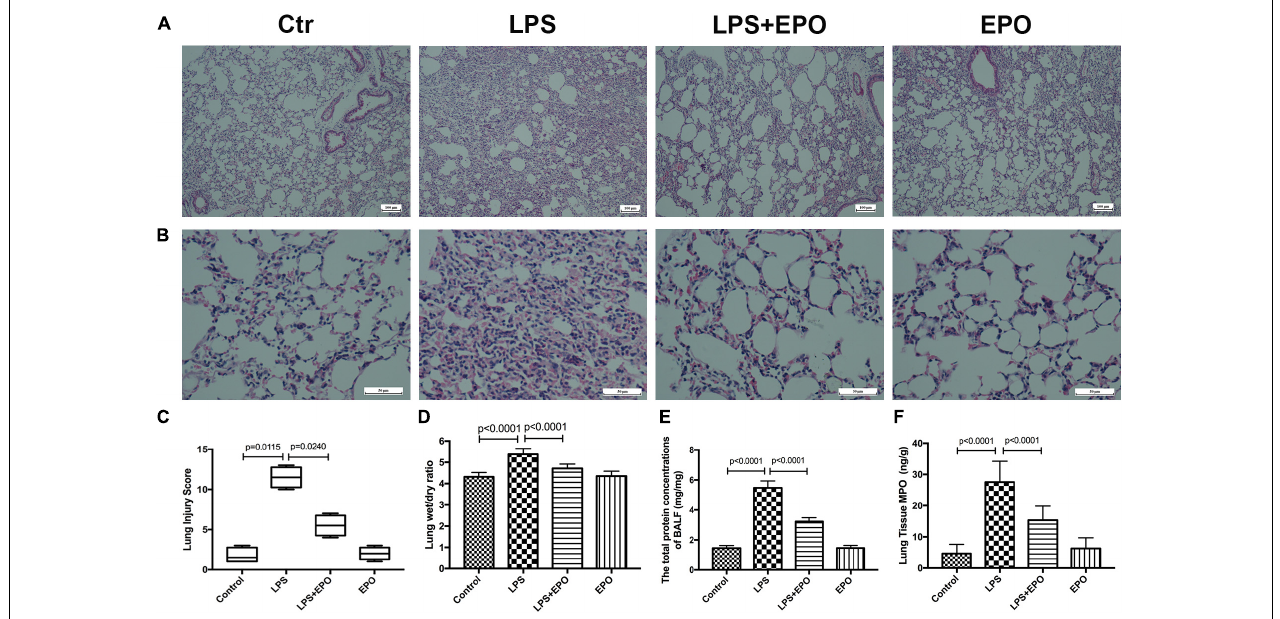
FIGURE 1 | EPO mitigated LPS-induced acute lung injury in mice. EPO (5 U/g) was injected into the peritoneal cavity of mice after LPS (15 mg/kg) stimulation. The mice were sacrificed 8 h later, and the effects of EPO were assessed in (A,B) hematoxylin and eosin-stained sections (original magnification × 100, × 400). Lung injury scores (C) were recorded from 0 (no damage) to 16 (maximum damage) according to the criteria described in Section “Materials and Methods.” The lung wet/dry ratio (D) was tested to evaluate pulmonary edema. The total protein concentrations in the BALF (E) were measured to reflect the integrity of the pulmonary alveolar-capillary barrier. Myeloperoxidase (MPO) concentrations in lung tissues (F) were measured by ELISA to quantitatively determine the resolution of infiltrated cells. The lung injury score data are presented as medians and ranges (5th–95th percentile), and the differences among groups were assessed by Kruskal–Wallis test and the post hoc test (Dunn’s method) was applied to investigate the differences one by one. n = 4 per group. The other data are presented as the mean ± SD. The differences of D – F were assessed by one-way ANOVA and the post hoc test (Turkey method) was applied to investigate the differences one by one. n = 8 per group.